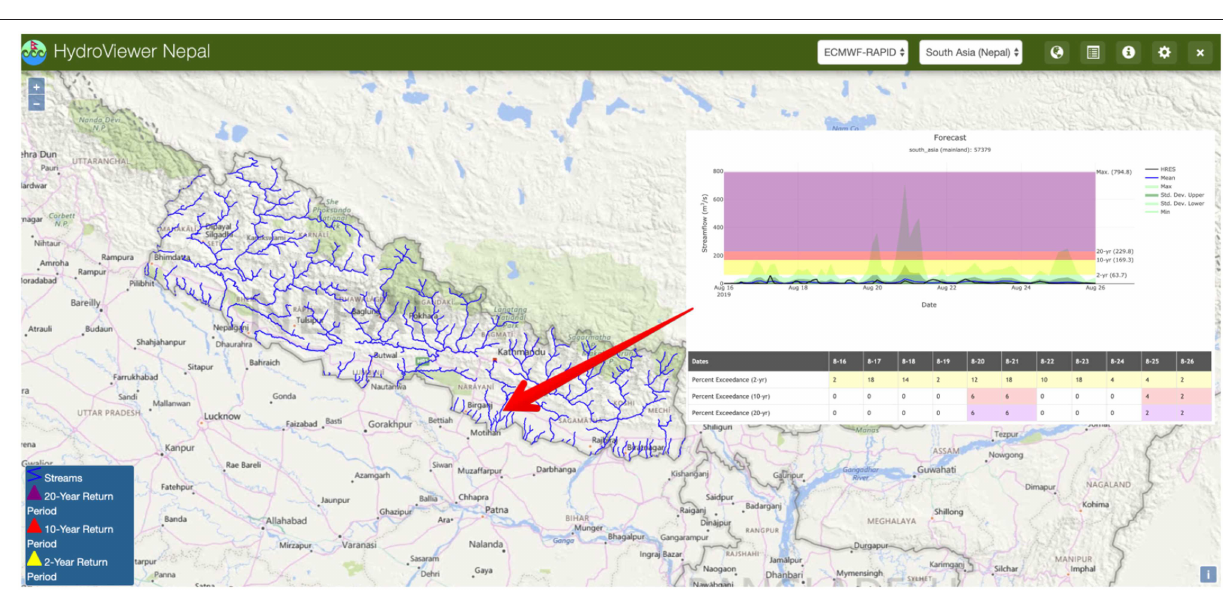
FIGURE 4 | HydroViewer app